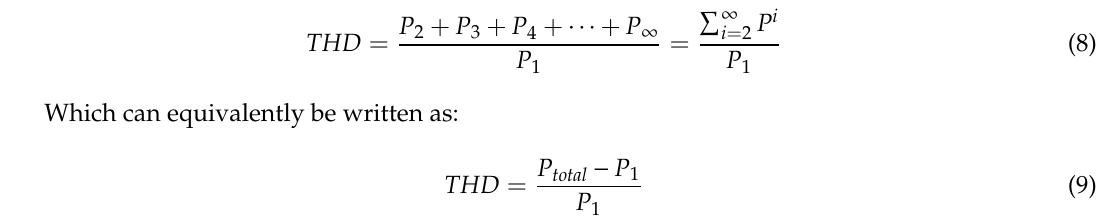
Table 9. Total harmonic distortion (THD).